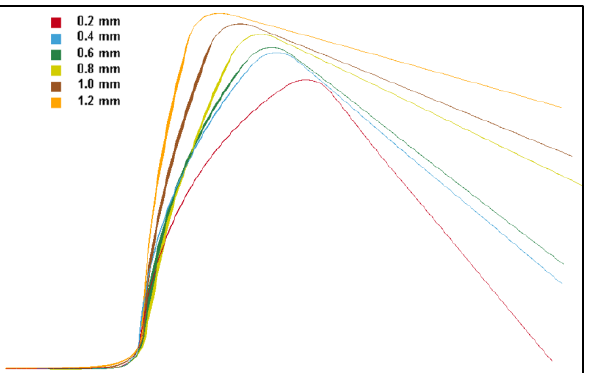
Figure 4. Springback profiles of single SA5182 U-channels with sheet thickness ranging from 0.2 mm to 1.2 mm.